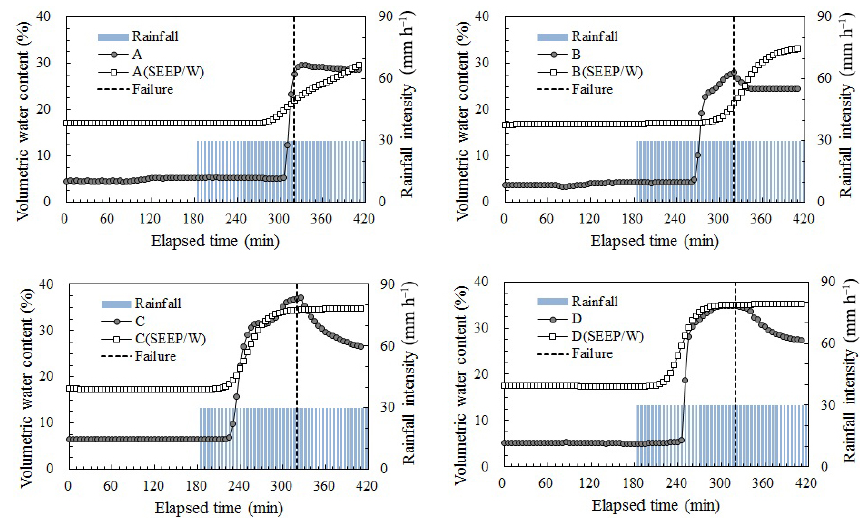
Figure 9. Comparison of volumetric water content of experimental data and results of numerical analysis in the model slope of 70 ◦ inclina- tion.